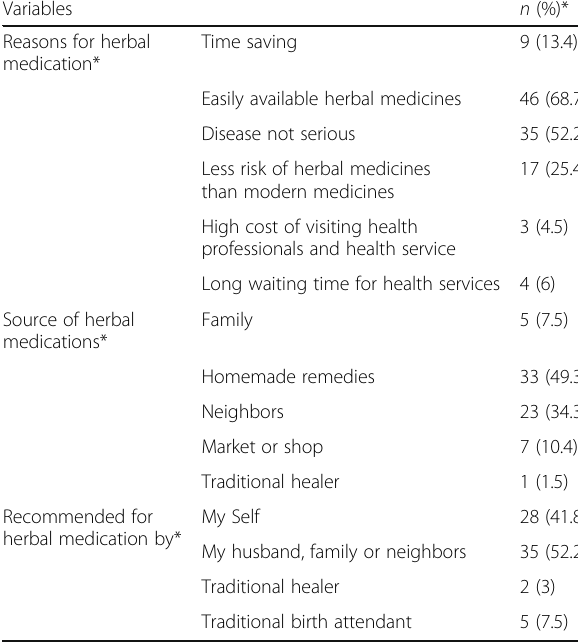
Table 4 Reasons for use, source of herbal medication, and recommendation for herbal medication of the